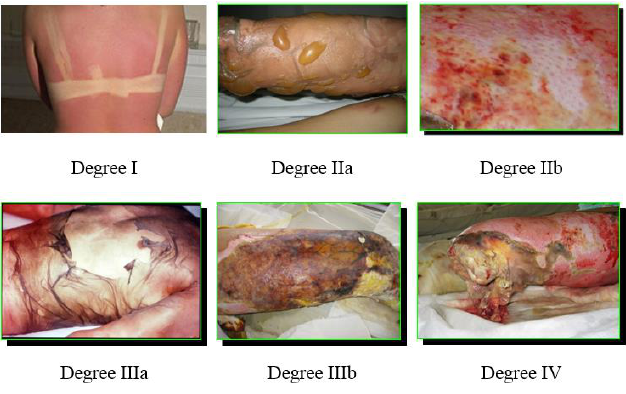
Fig. 14. Illustration for degreses burning